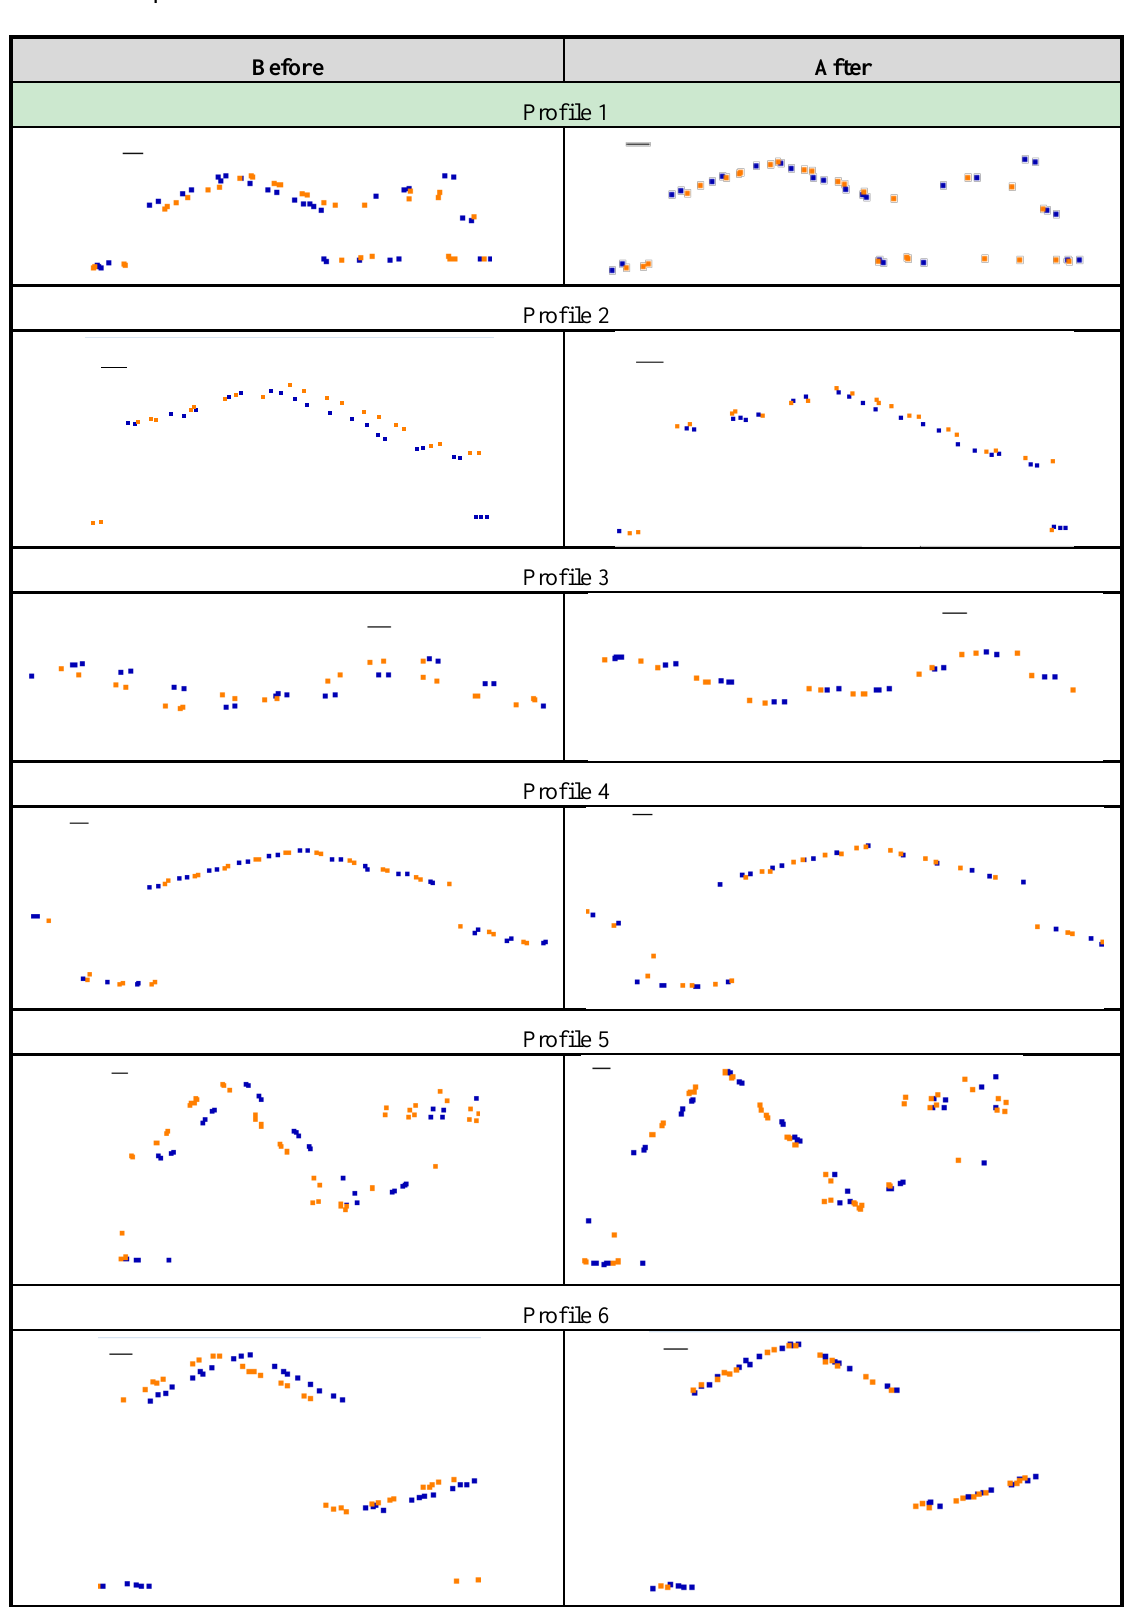
Figure 8. Profiles in overlapping strips 1&2 (refer to Figure 7 for the location of these profiles) showing the degree of compatibility between the point cloud before and after the calibration